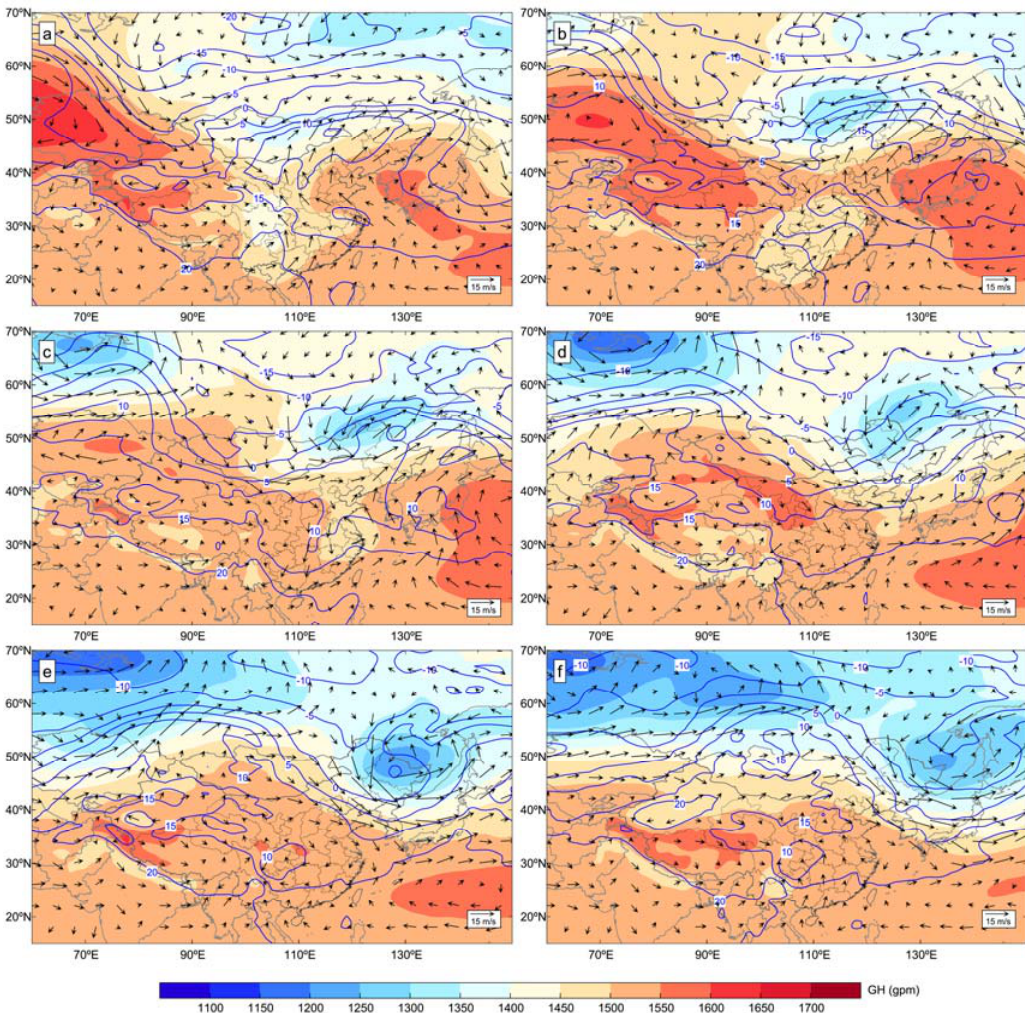
Figure 11. Variation of the geopotential height ( shading ), wind field and temperature ( contours ) at 850 hPa on 2 – 7 May 2017(sub ‐ graph (a) to (f) respectively describe the geopotential height, wind field and temperature at 850 hPa on 2 – 7 May 2017).